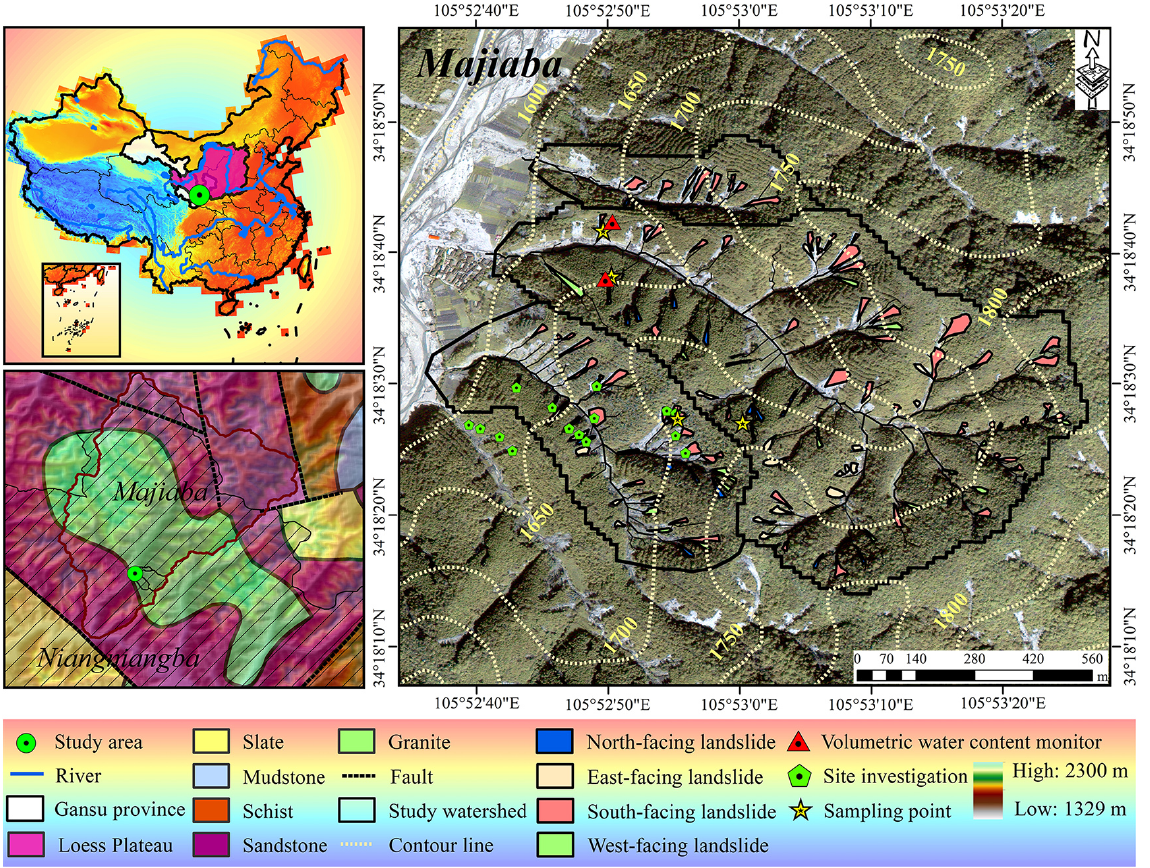
Figure 1. Location, topography, and simplified lithology of the study area. All maps are created by the authors. The graph of Majiaba was taken using an unmanned aerial vehicle. The territorial domain of China and the simplified lithology map are from the China Geological Survey. The elevation legend refers to the mountain area spanning Niangniangba and